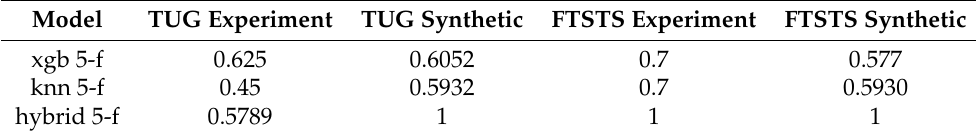
Table 2. Accuracy results of XGBoost, k -NN, and hybrid models using the test dataset.